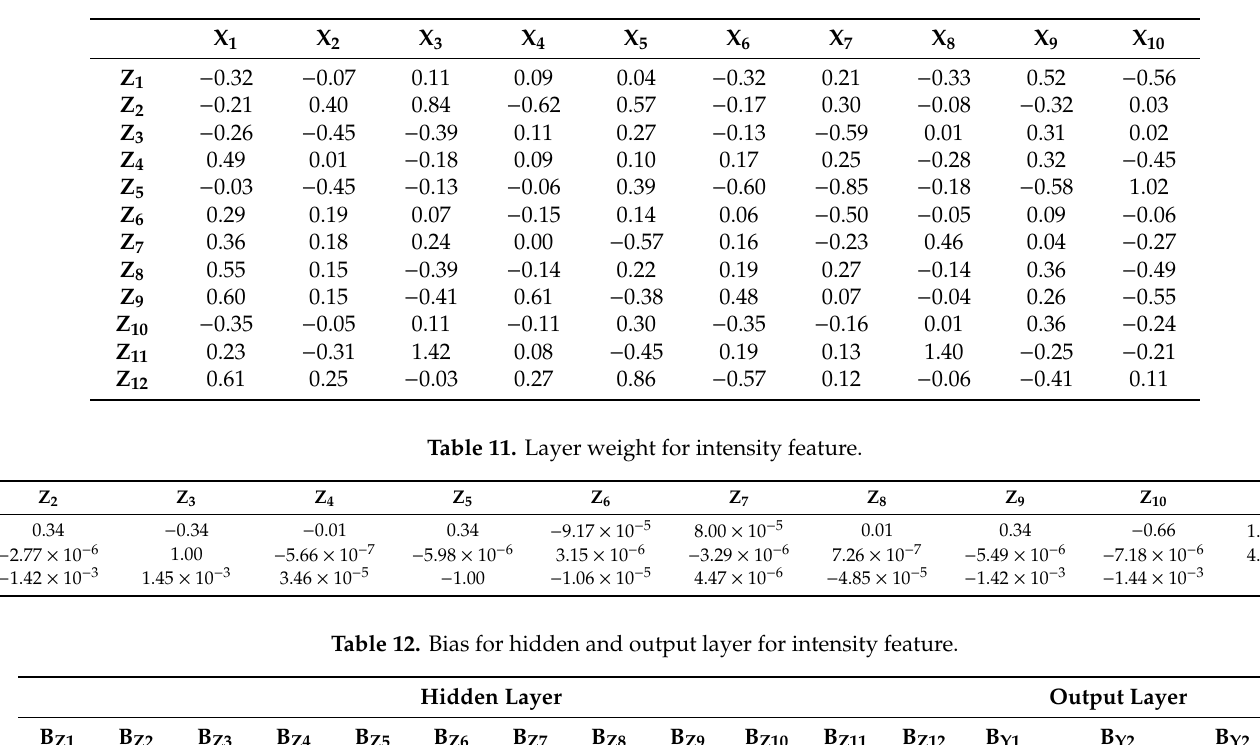
Table 10. Input weight for intensity feature.